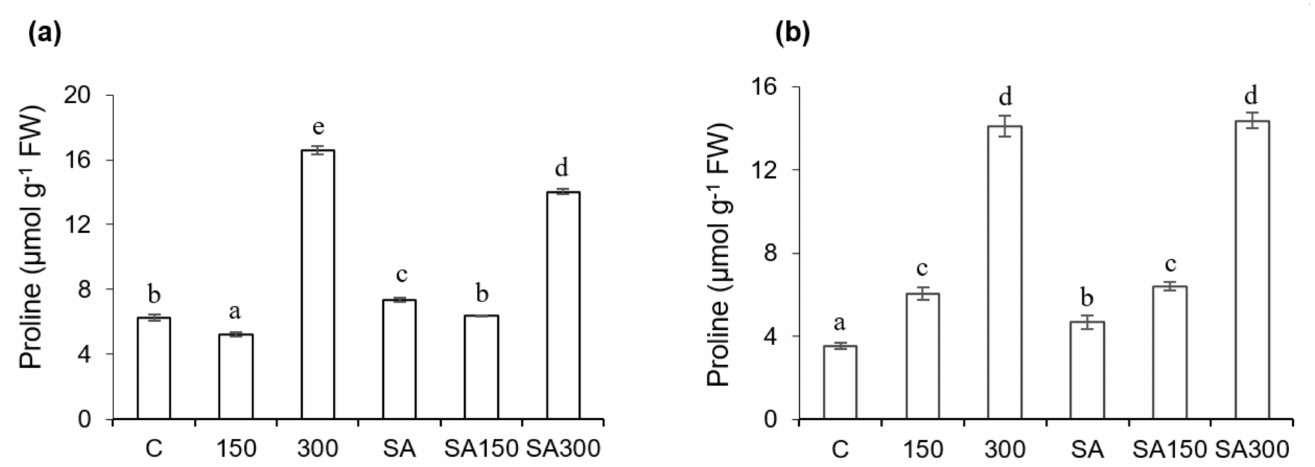
Figure 2. Effect of salicylic acid (SA) pre-treatment on proline content of Hordeum vulgare L. ‘Ince-04 (cid:48) plants. Leaves ( a ) and roots ( b ) under control and saline conditions (150 and 300 mM NaCl). Different letters indicate significant differences between treatments ( p <